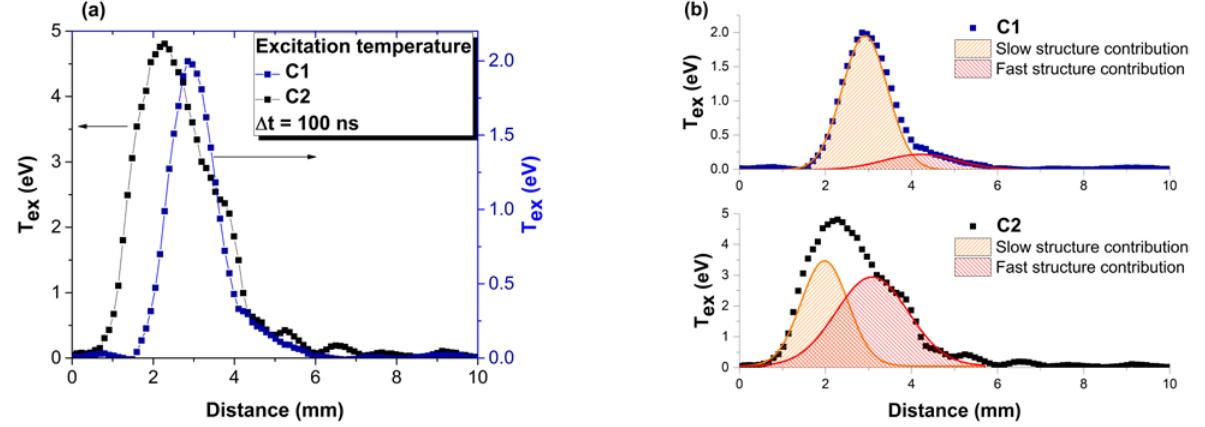
Figure 5. Spatial evolution of electron excitation temperature after 100 ns ( a ) and the deconvolution